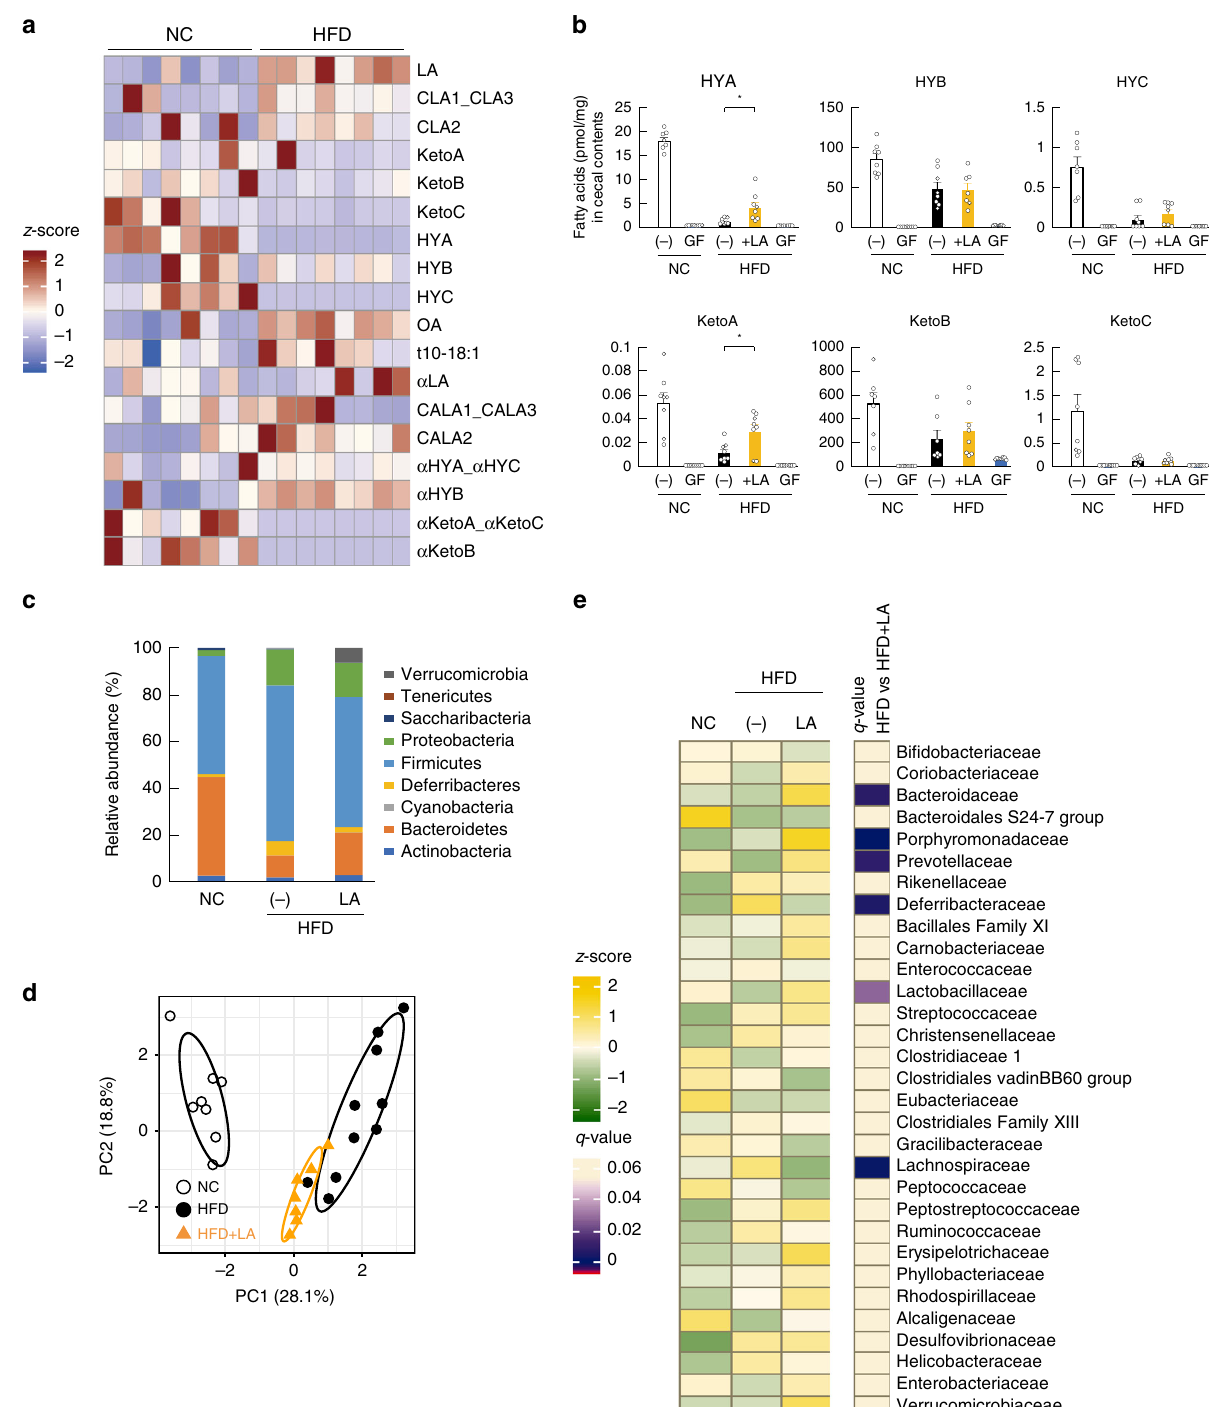
Fig. 1 Effects of dietary PUFAs on gut microbiota composition and PUFA metabolites. a Heat map of gut microbial PUFA metabolites in cecal content ( n = 8 per group). b LA-derived gut microbial PUFA metabolites in cecal content were quanti fi ed ( n = 7, 10, 8, 8, and 8 per group for HYA; n = 8,10, 8, 8, and 8 per group for HYB; n = 7, 10, 8, 8, and 10 per group for HYC; n = 8, 10, 8, 8, and 10 per group for KetoA; n = 7, 10, 7, 8, and 8 per group for KetoB; n = 8, 9, 8, 8, and 8 per group for KetoC). * P < 0.05 (Tukey – Kramer test). c – e Gut microbial composition was evaluated in order to determine the relative abundance of microbial taxa ( c ), diversity ( d ), and abundance of the bacterial domain at the family level ( e ) ( n = 8, 10, and 7 per group). ( − )_NC represents normal chow-fed mice, and ( − )_HFD represents high-fat diet-fed mice. q < 0.05. Results are presented as means ± SE. Source data are provided as a Source Data fi le